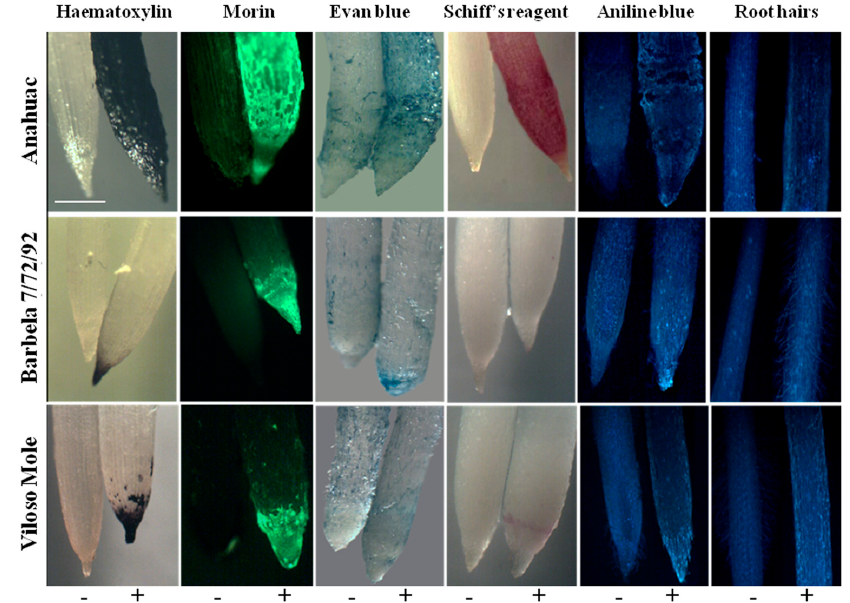
Figure 2. Physiological responses of the roots of Al sensitive (Anahuac) and Al-tolerant (Barbela 7/72/92 and Viloso Mole) bread wheat genotypes under control [0 μ M Al ( − )] and Al stress [74 μ M Al (+)] conditions. Note: These genotypes were characterized for their response to Al stress by localization of root Al (hematoxylin), Al accumulation (Morin assay), plasma membrane integrity loss (Evans blue), lipid peroxidation (Schiff’s reagent), callose formation (Aniline blue) and root hair development. Horizontal scale bar indicates 250 μ m.